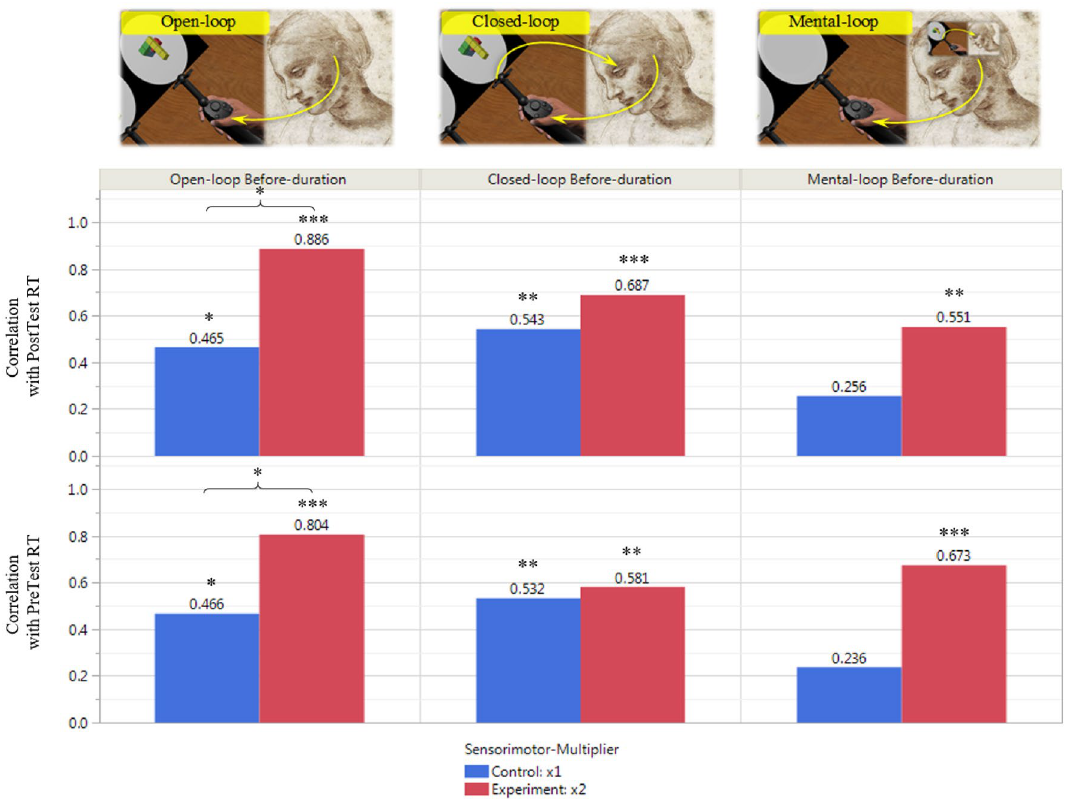
Figure 6. Correlations of mental-motor individual capacities by condition group. Pearson’s r correlations between individual motor-planning and mental-rotation mean durations, per motor-control mode and mental- rotation pretest/posttest blocks, separately for each Sensorimotor-Multiplier (virtual speed alteration) condition group of subjects. Statistical significance levels are denoted with